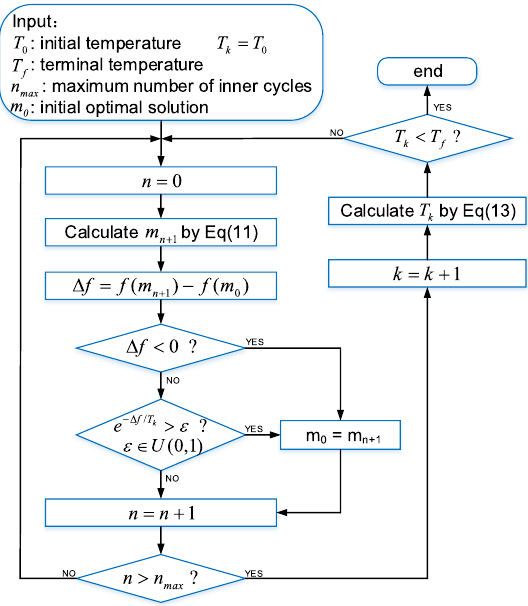
Figure 15. Flow of adaptive simulated annealing (ASA) algorithm.